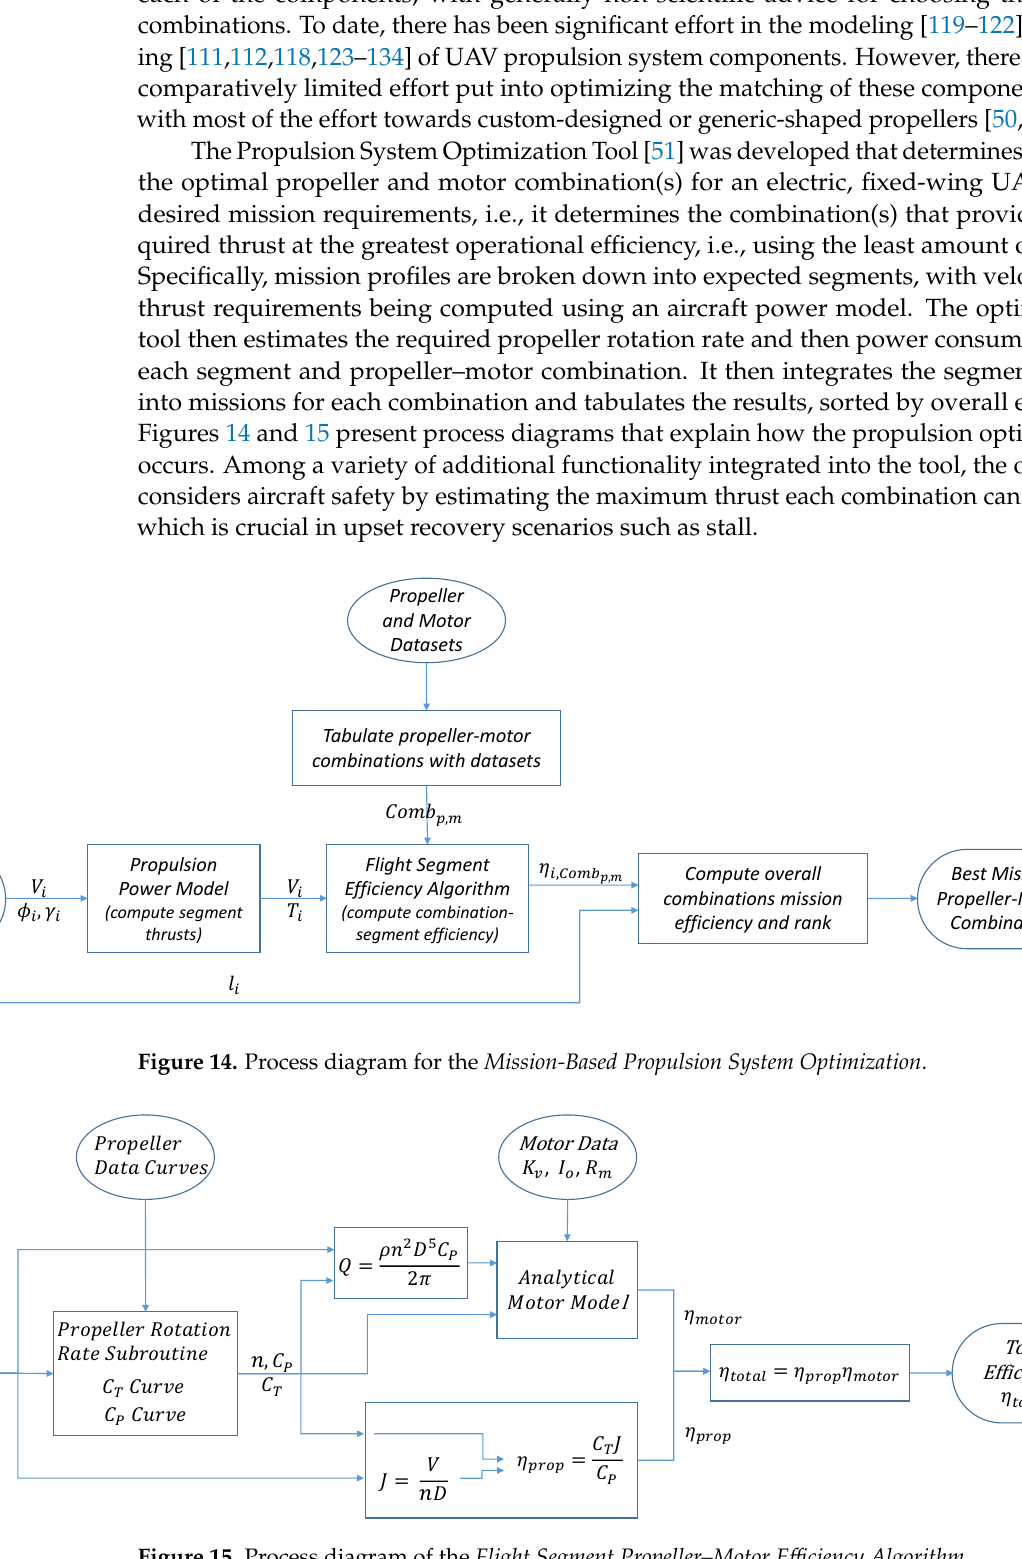
Figure 15. Process diagram of the Flight Segment Propeller–Motor Efficiency